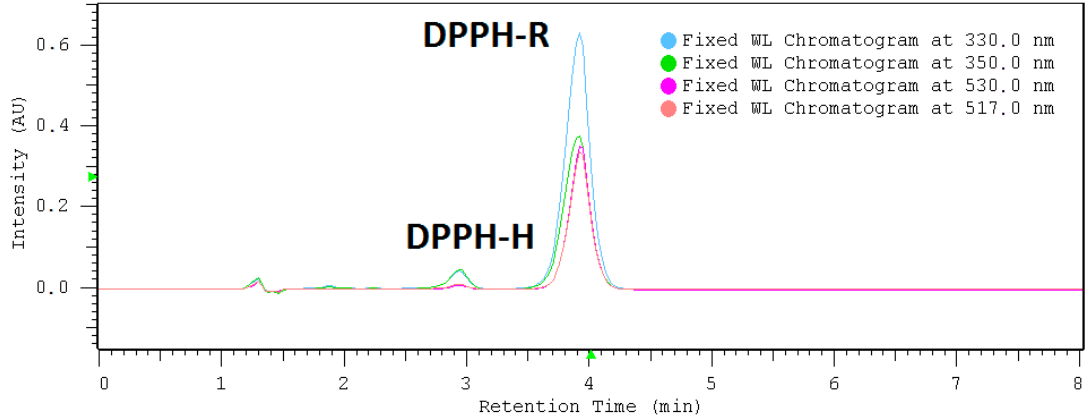
Figure 1. Overlapped chromatograms of DPPH (2,2-diphenyl-1-picrylhydrazyl radical (DPPH • (DPPH-R)) standard solution in methanol (0.7 mM) recorded at different wavelengths on Zorbax Eclipse column and 80% ( v / v ) MeOH/water.